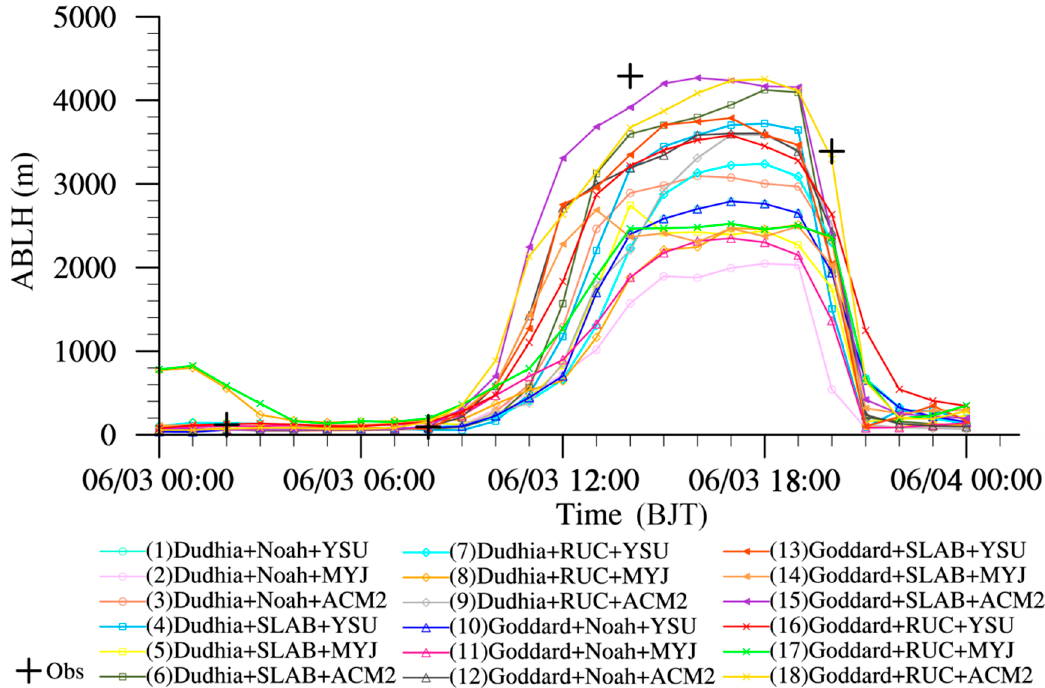
Figure 8. Numerical simulation of Dunhuang using different combinations of parameterization schemes and calculation of boundary layer heights with ERA-Interim model level data from 16:00 on 2 June, 2016, to 16:00 on 3 June, 2016.